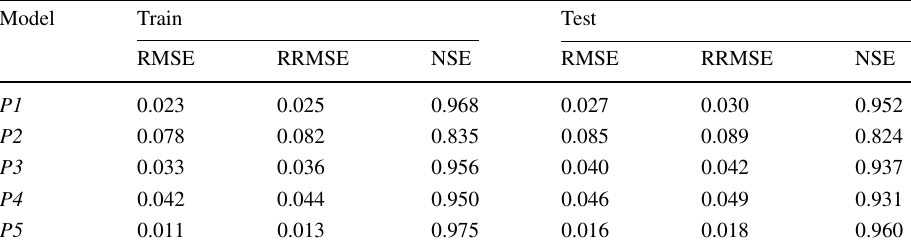
Table 11 Evaluation of the different scenarios in estimating WP and WPe